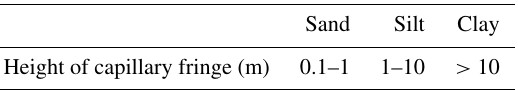
Table 1. Values for the capillary fringe height, regarding the lithol- ogy, after Gillham